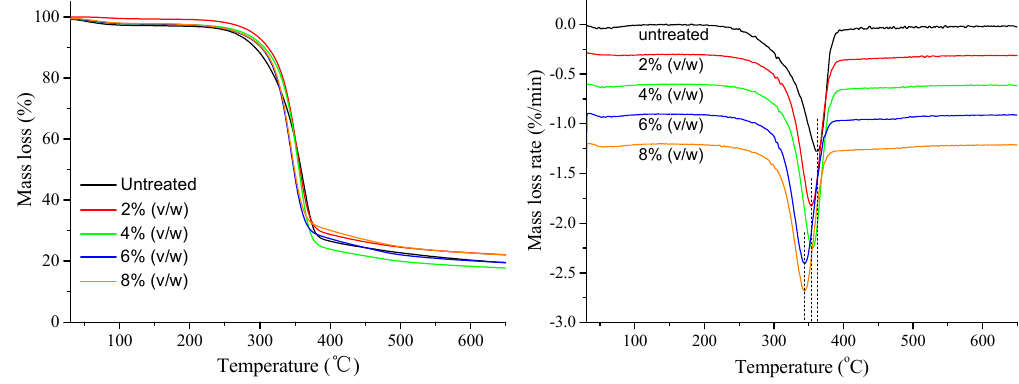
Figure 4. TG spectra of untreated and modified fibers with 2%, 4%, 6%, and 8% ( v / w ) MTCS dosages.